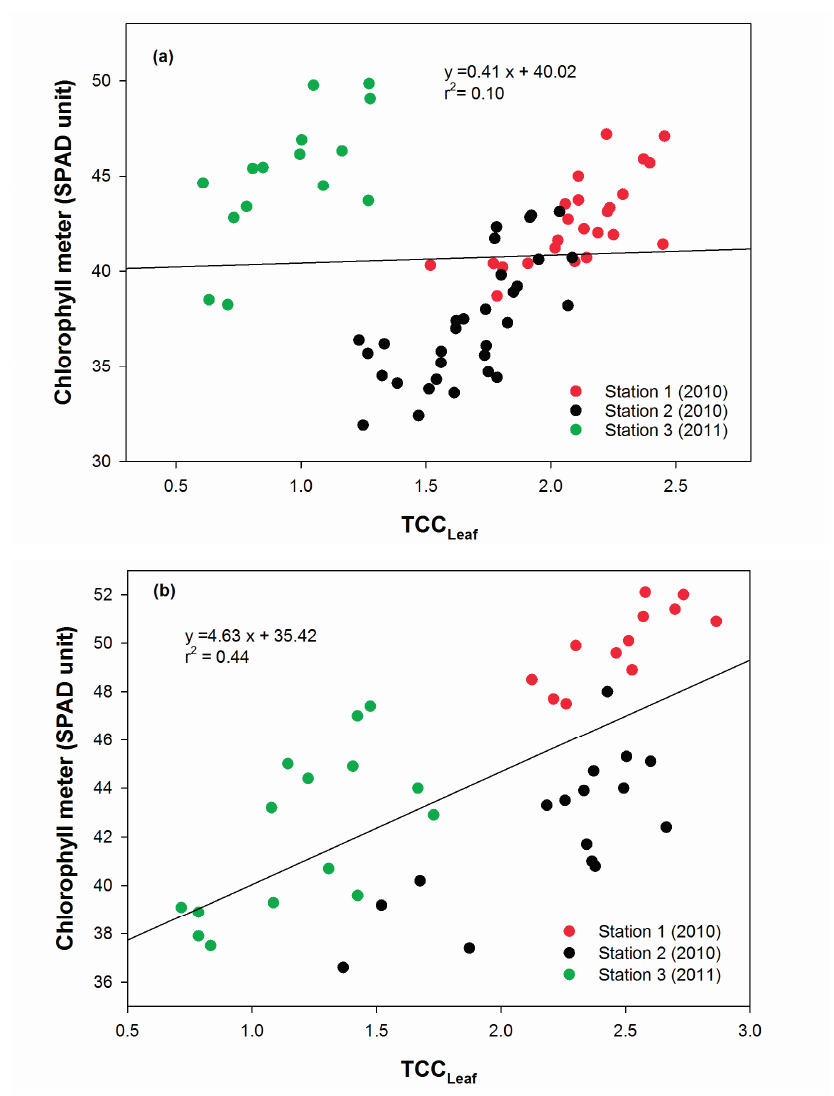
Figure 4. Linear regression between TCC Leaf and chlorophyll meter readings at ( a ) mid to late squaring, and ( b ) early